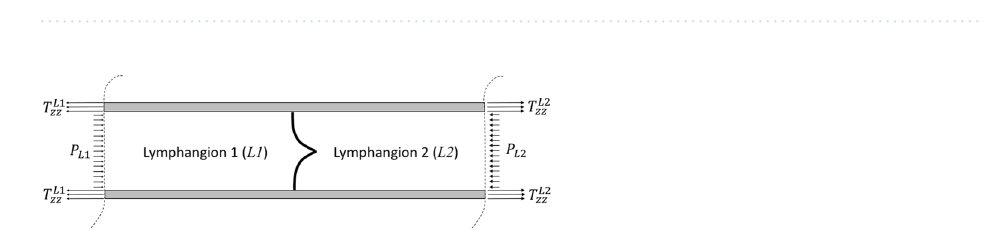
mechanics of lymphatic vessels. The mechanical properties of a load bearing tissues depend on the anisotropic architecture of collagen fibers, with the predominant collagen fiber direction correlating to increased stiffness in that direction. The current observation suggest that the predominant axial orientation of collagen fibers provide structural support for axial loads due to in vivo axial stretch, perhaps serving to regulate change in axial stretch throughout the pumping cycle. Collagen organization and fiber recruitment are important factors that not only determine the passive function but also influence the contractile function of lymphatic vessels. Recent multipho- ton imaging of collagen fibers within the wall of the pelvic lymphatic vessel has shown that the fibers are predom- inately oriented in the axial direction 41 . Similar results were found for the bovine 42 and rat lymphatics, although